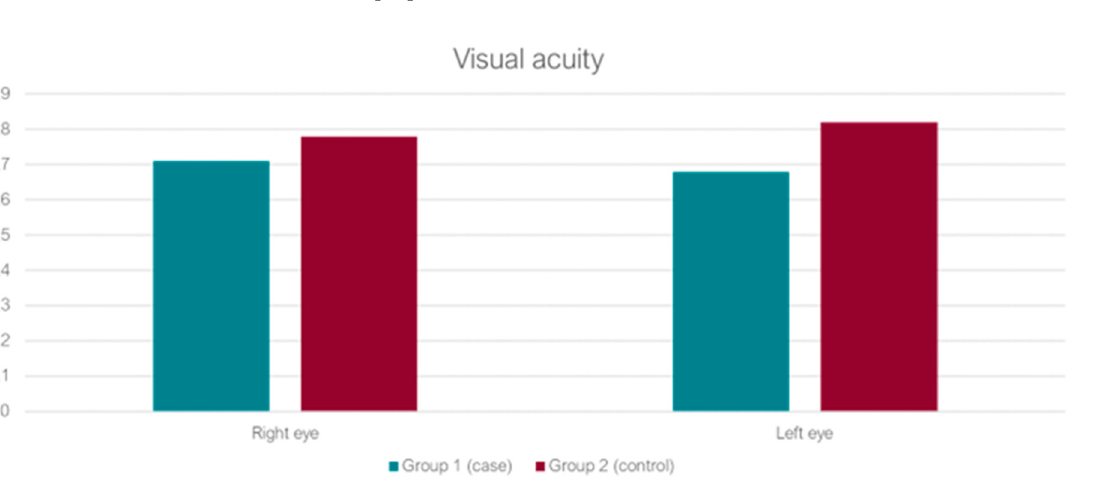
Figure 1. Visual